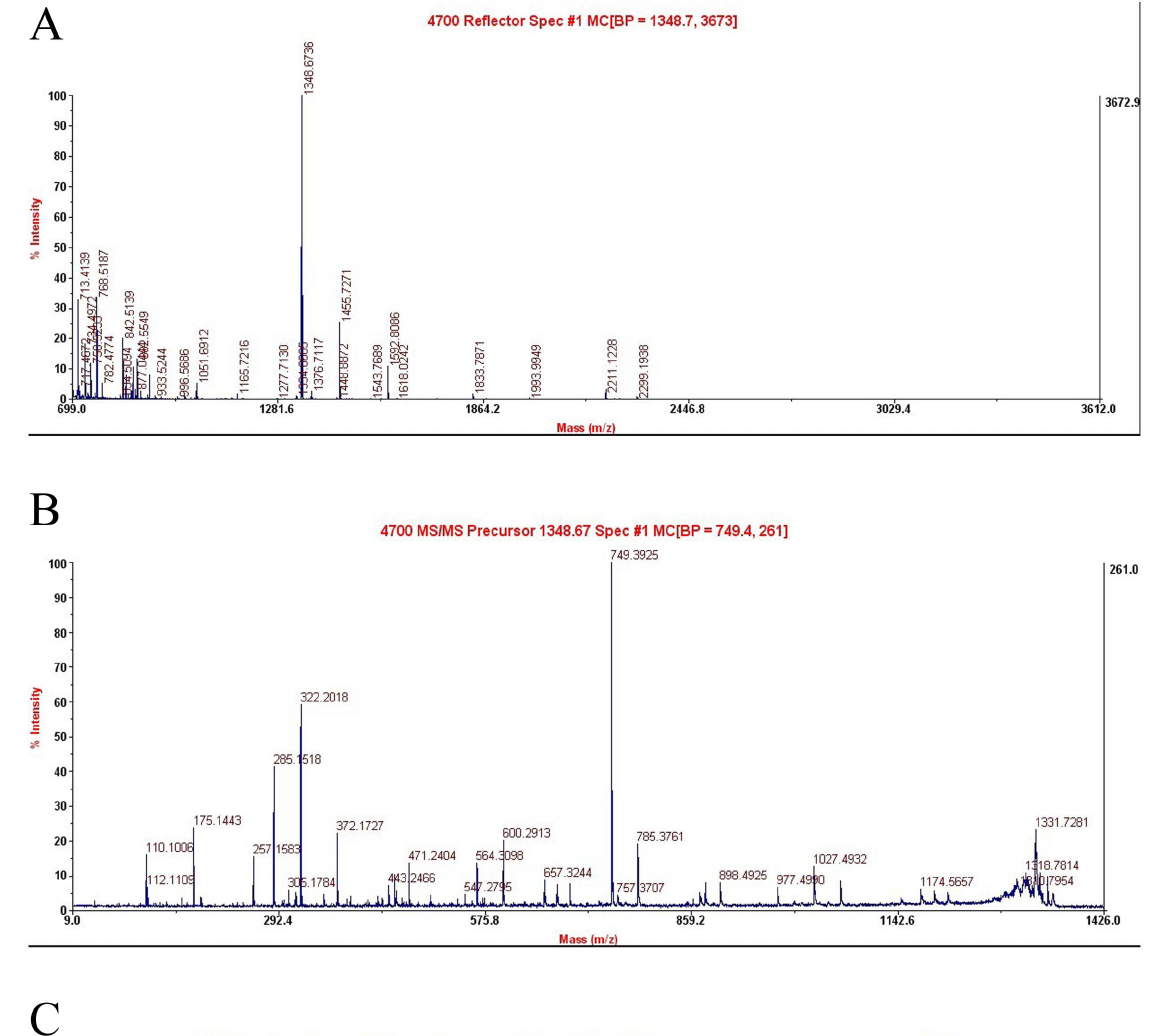
Figure 2. A: MALDI/Mass spectrum of the protein spot of HSP90 identified using MALDI-TOF-MS. B: MALDI-TOF-TOF mass spectrum of the mixture of tryptic peptides derived from Spot 10 (HSP90); C: Matching of protein Spot 10 (HSP90) Peptide Mass Fingerprint data in database.